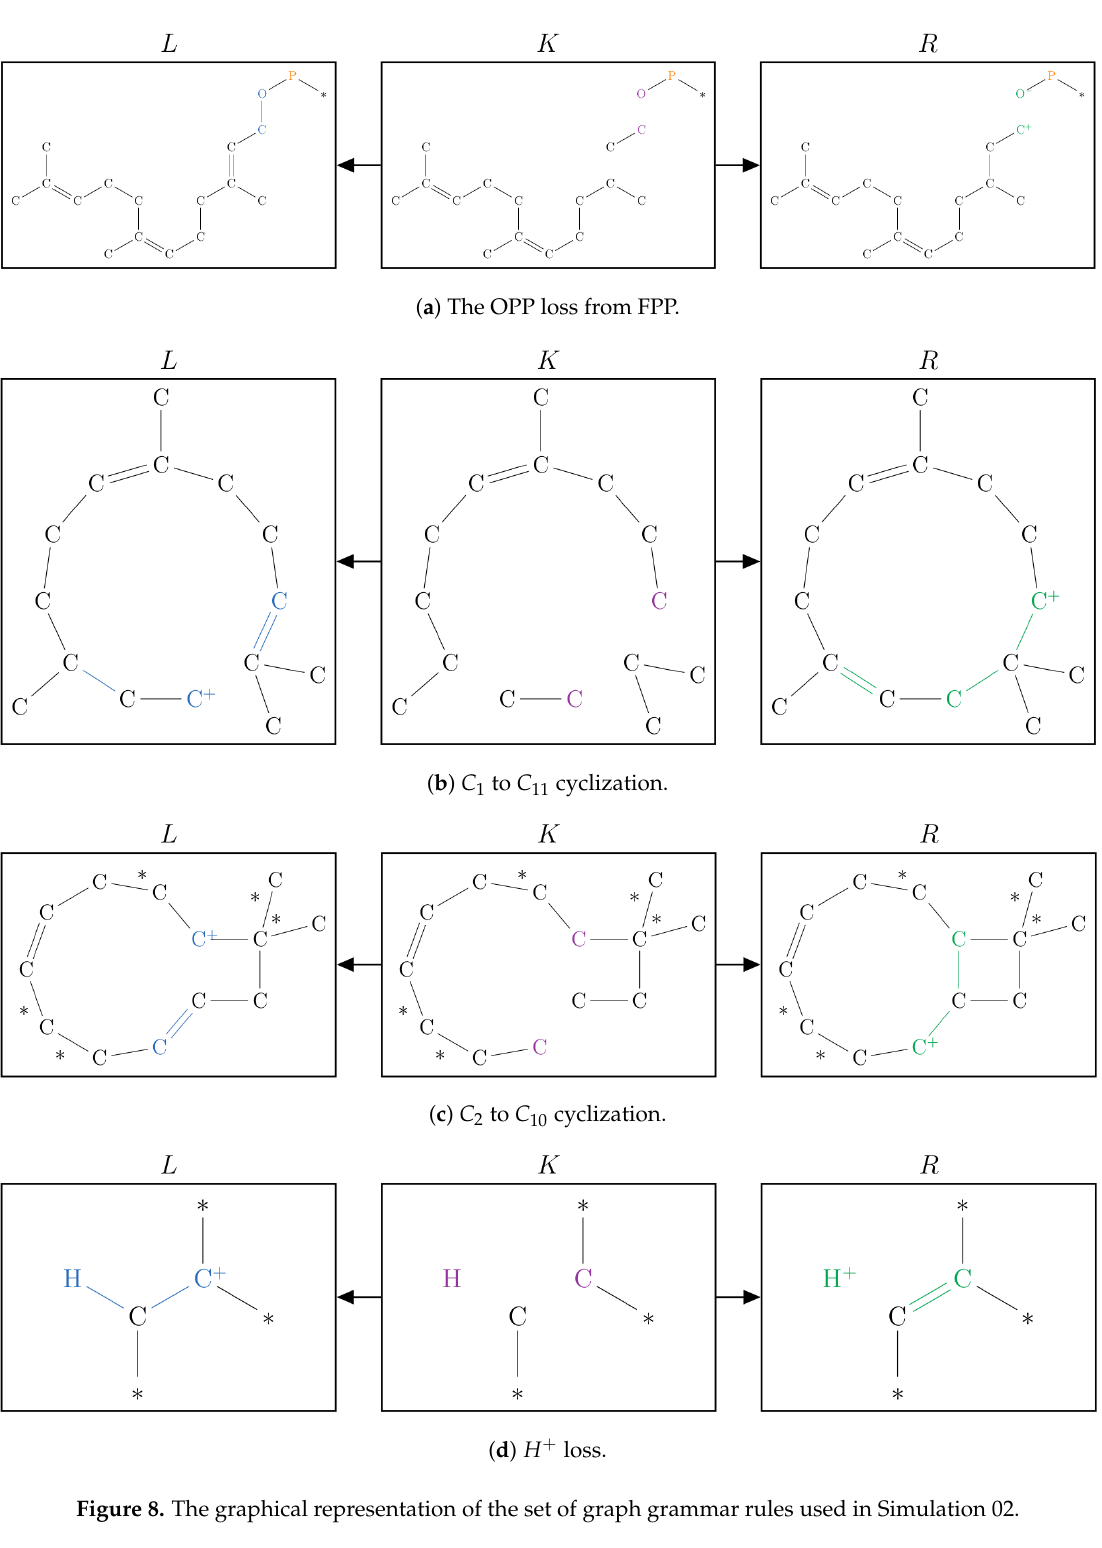
Figure 8. The graphical representation of the set of graph grammar rules used in Simulation